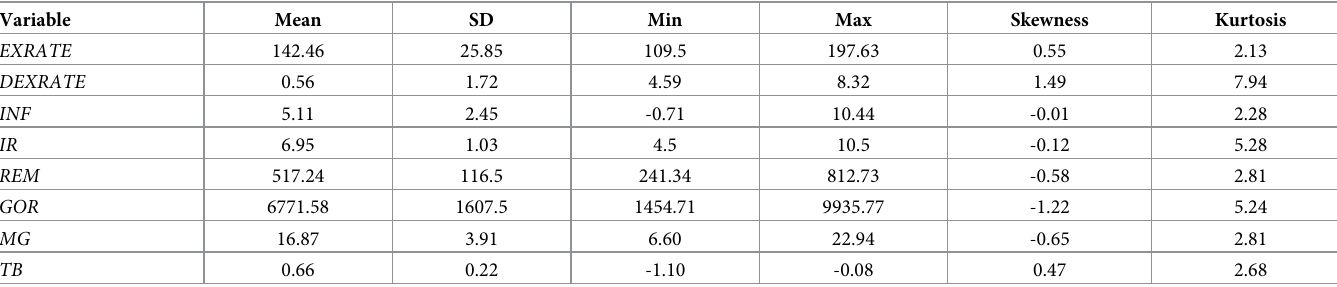
Table 1. Summary of descriptive